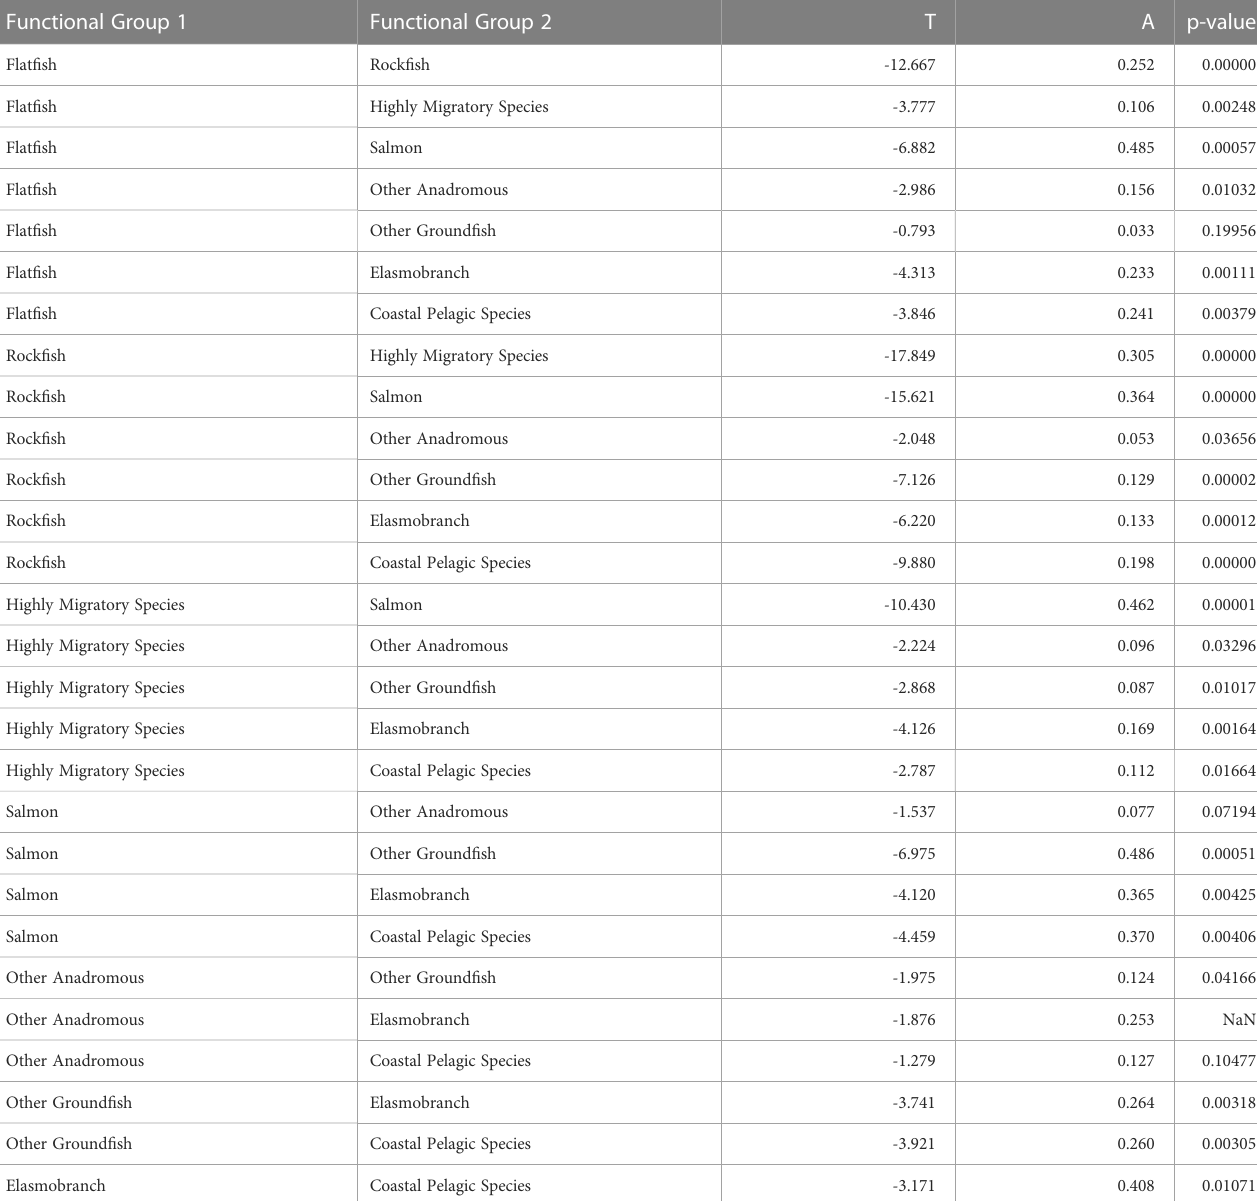
TABLE 5 Multi-Response Permutation Procedures results showing pairwise comparisons of functional groups in exposure and sensitivity characteristics. Functional Group